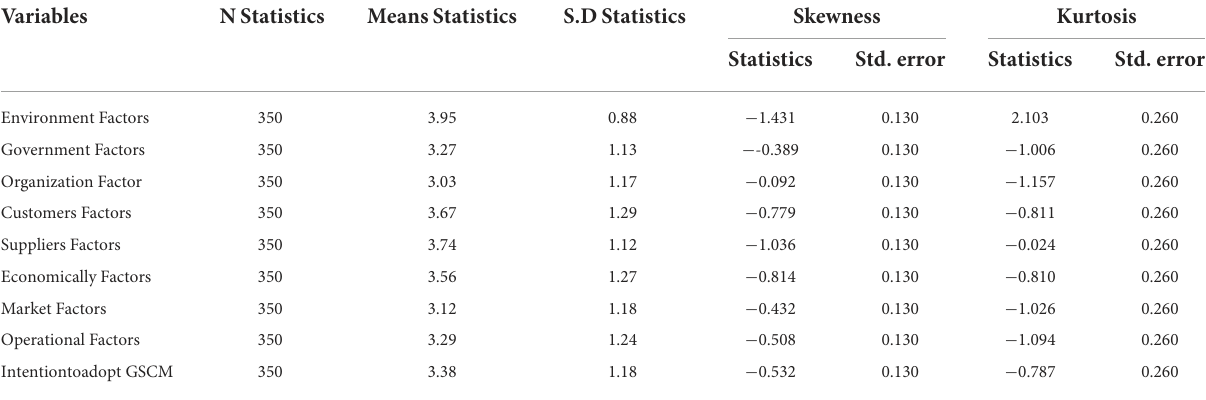
FIGURE2 The skewness and kurtosis distributions.